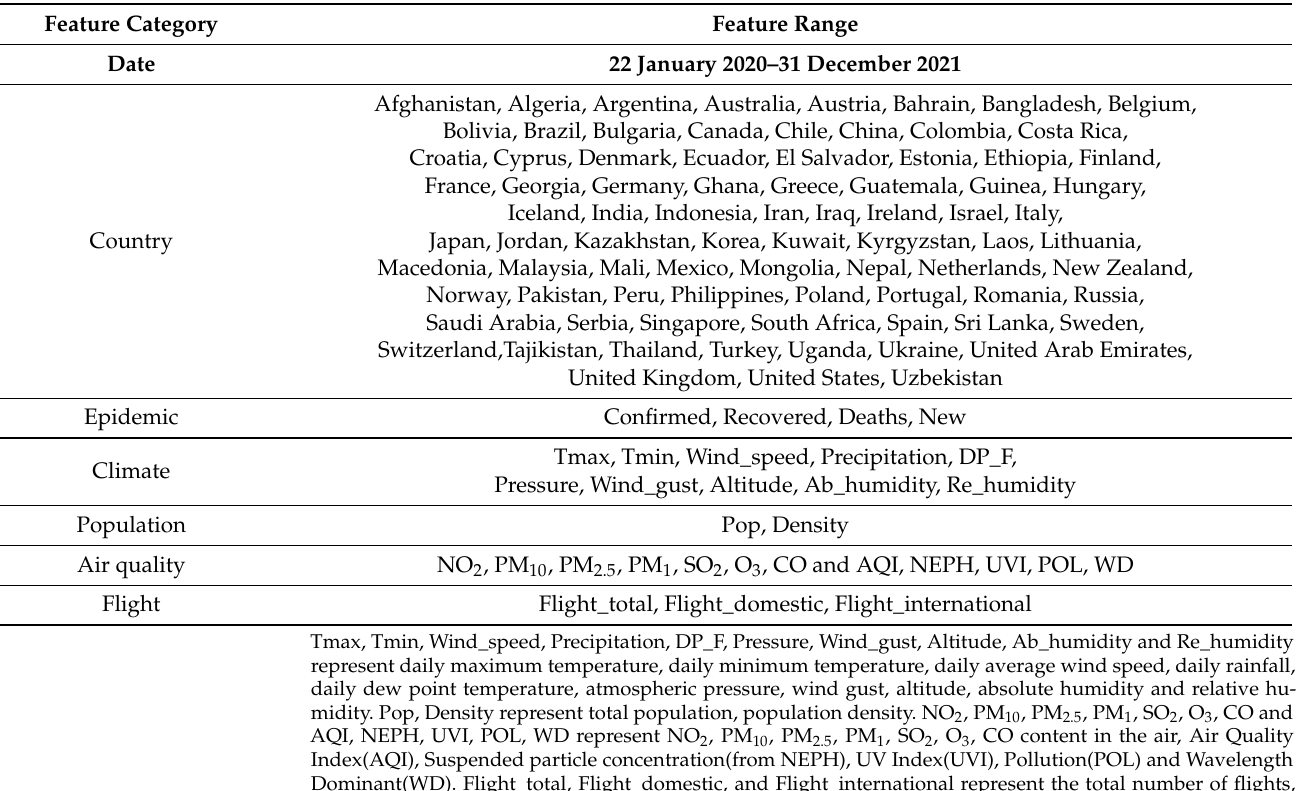
Table 1. Feature display of fusion data